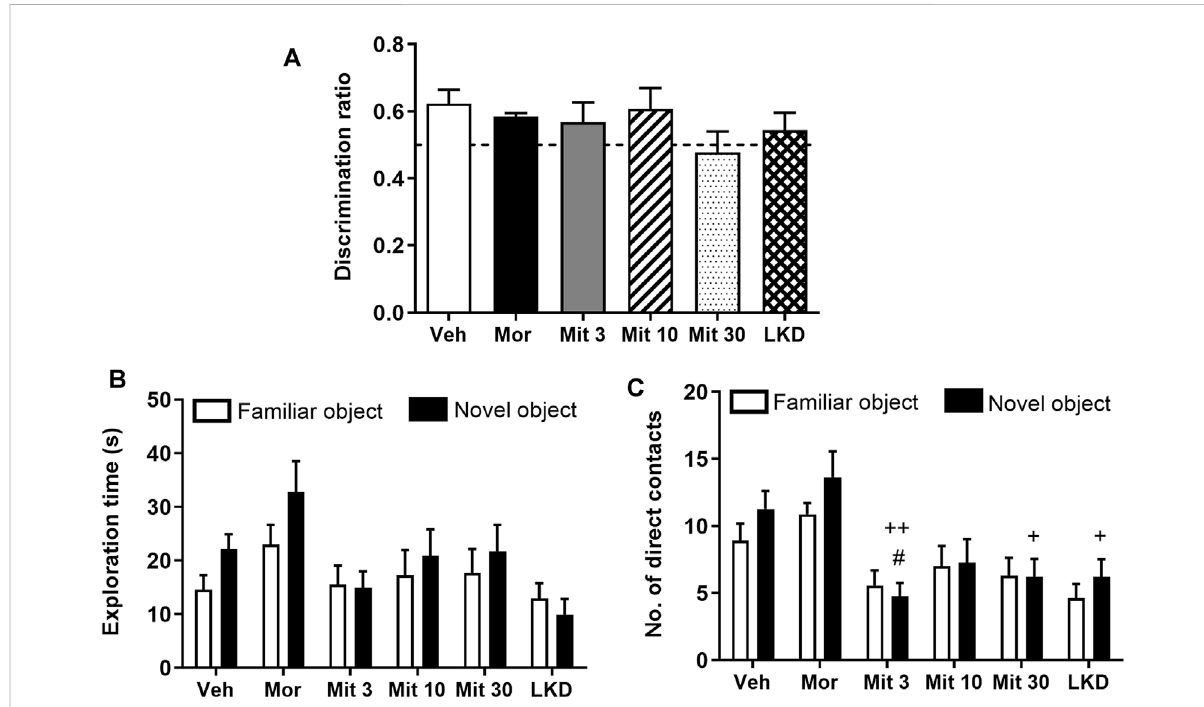
FIGURE 3 Effects of adolescent kratom exposure on (A) Discrimination ratio after 24-h retention interval, (B) Exploration time on both familiar and novel objects, and (C) Number of direct contacts with both familiar and novel objects. Data are expressed as mean ± SEM ( n = 8 – 10). # p < 0.05, vs. novel object of the vehicle-treated group; + p < 0.05, ++ p < 0.01, vs. novel object of the morphine-treated group.